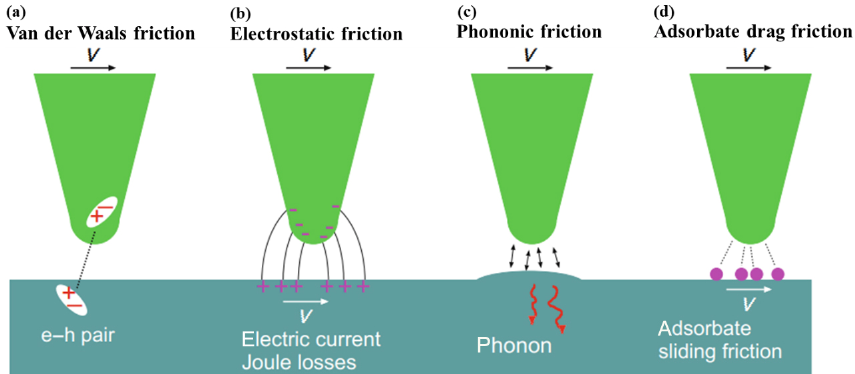
Fig. 6 (a) Van der Waals friction, (b) electrostatic friction, (c) phononic friction, and (d) adsorbate drag friction. Reproduced with permission from Ref. [87], © Springer-Verlag Berlin Heidelberg